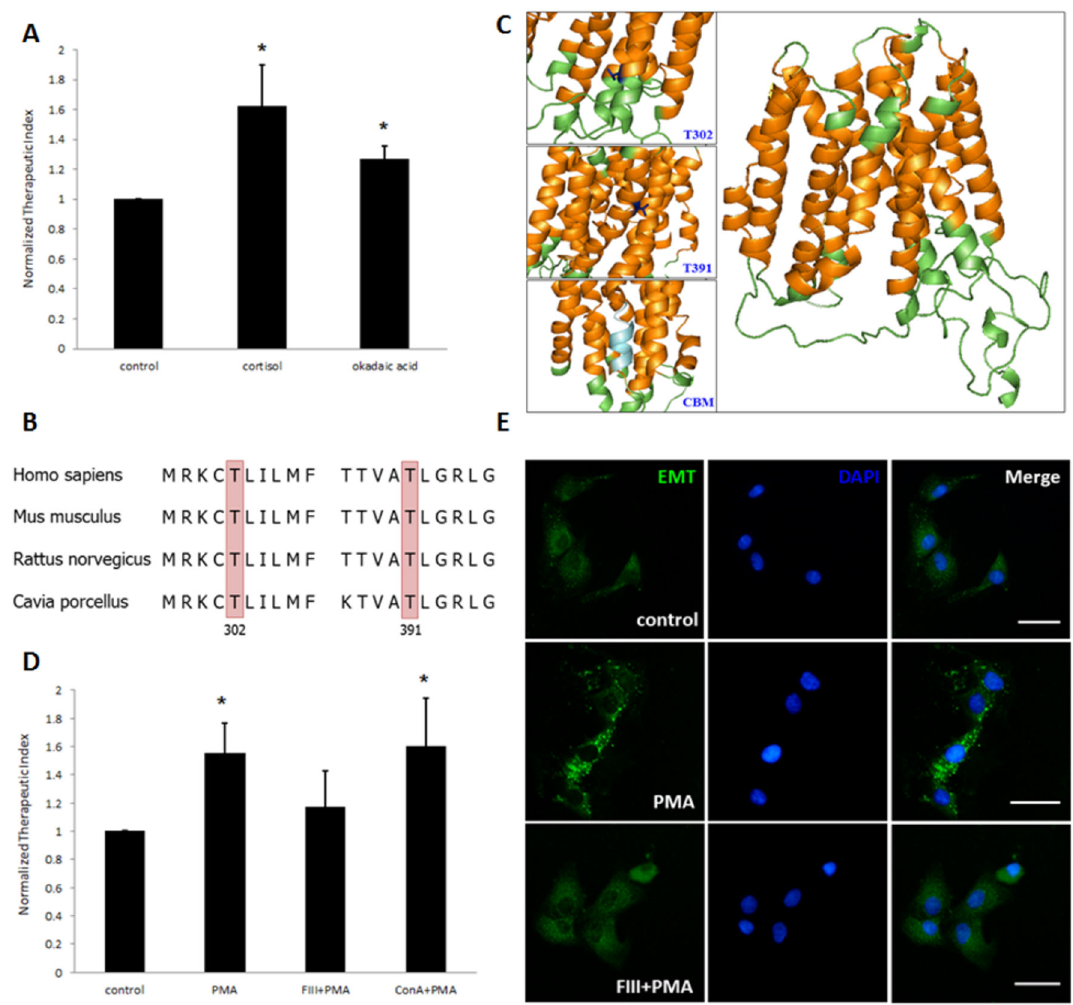
Figure 4. Protein kinase C (PKC) phosphorylates EMT and induces EMT internalization. A , okadaic acid, an inhibitor of protein phosphatase PP1/2A, partially imitated the permissive action of cortisol (n=3 in each group), * p <0.05 vs . control. B , bioinformatics analyses of guinea pig EMT amino acid sequence revealed threonine 302 and 391 as consensus PKC site, which were also conserved across species. C , an overall view of predicated guinea pig EMT, showing transmembrane (TM) helices in orange. Other residues were represented in green. Two consensus PKC site, one located at juxtamembrane region (Thr302) and the other in TM helix were depicted in blue (upper and middle insets). A typical caveolin-binding motif (CBM) was also shown in silver (lower inset). D , endocytic inhibitor filipin III (FIII), but not concanavalin A (ConA) blocked the permissive effect induced by PKC activator, PMA (n=4 in each group). E , immunofluorescent staining of EMT in vascular smooth muscle cells with different pharmacological manipulation (upper three subpanels, control; middle three subpanels, PMA treatment; lower three subpanels, filipin III exposure and then PMA treatment). The nuclei were stained blue with DAPI, and EMT was stained green by the immunofluoresence method. Scale bar: 20 μm. doi: